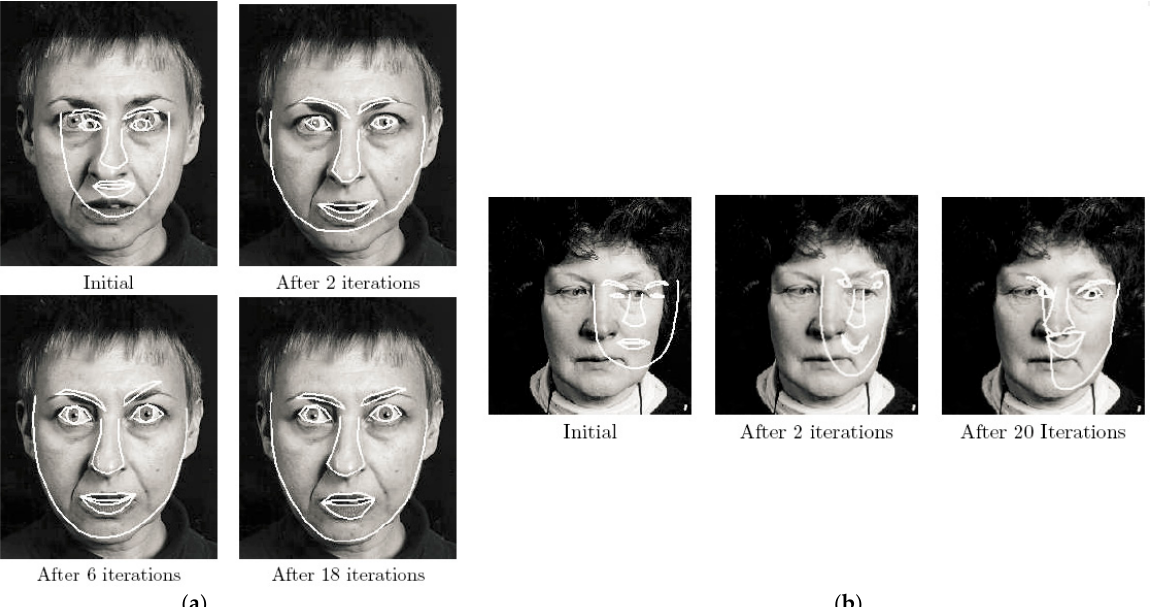
Figure 3. Illustrates the search with ASM for the face. ( a ) In the case of a point being near the target; ( b ) shows how the ASM can break down if the starting position is too far from the target